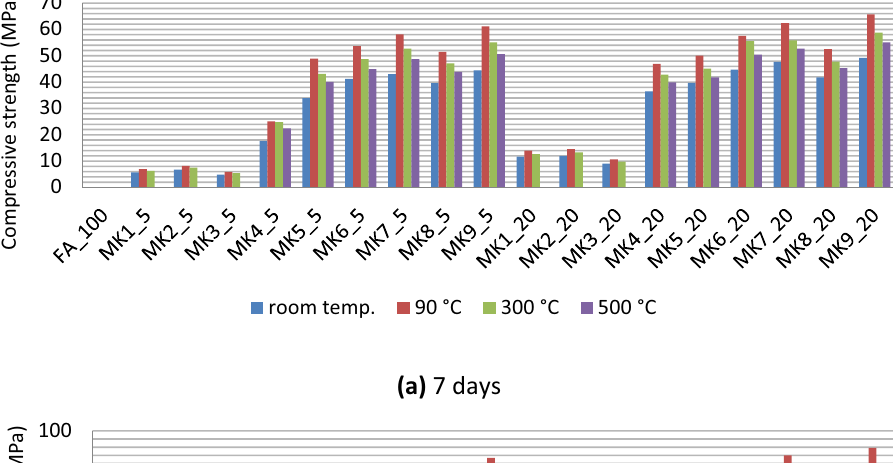
Fig. 6 Compressive strength evolution at different tempera- tures at a 7 days, b 56